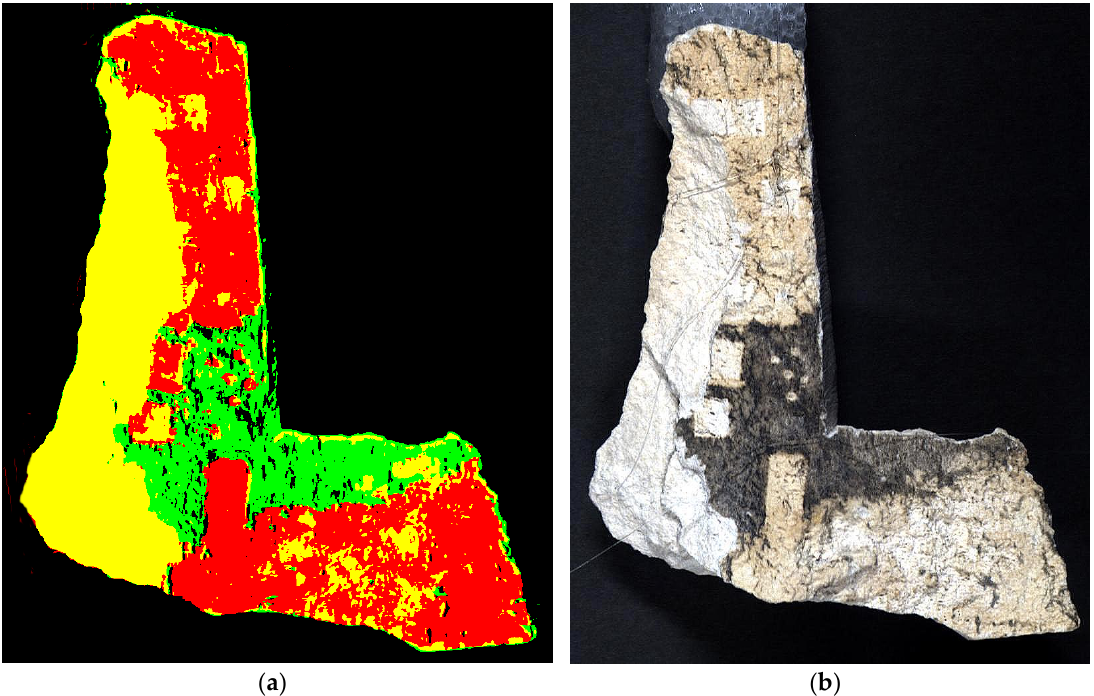
Figure 7. The spectral angle mapper (SAM) classification map applied to the 950–1650 nm range ( a ). Endmembers spectra are those of P1, P2 and P3 reported in Figure 4b. The RGB image reconstructed from the HSI data for a direct comparison with the map and a visual localization of the treated and untreated areas ( b ).